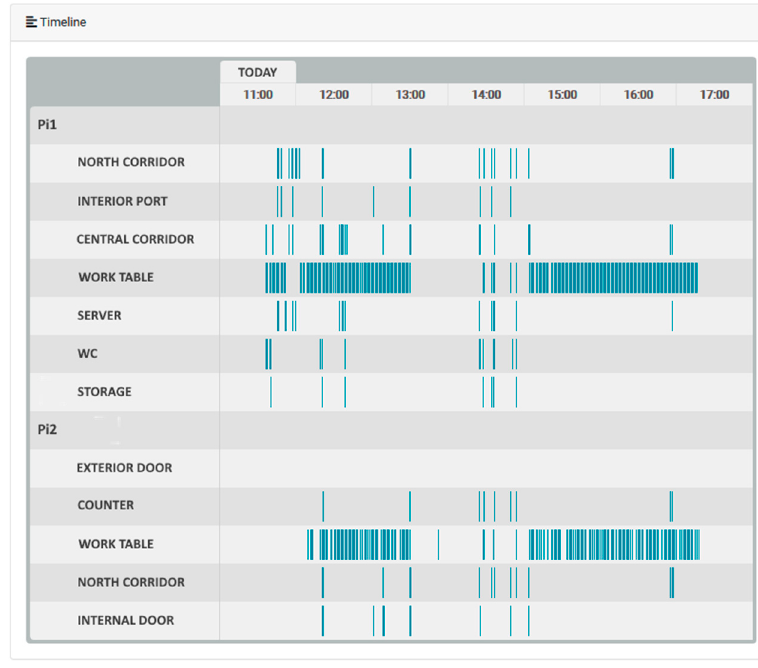
Figure 11. Event timeline.